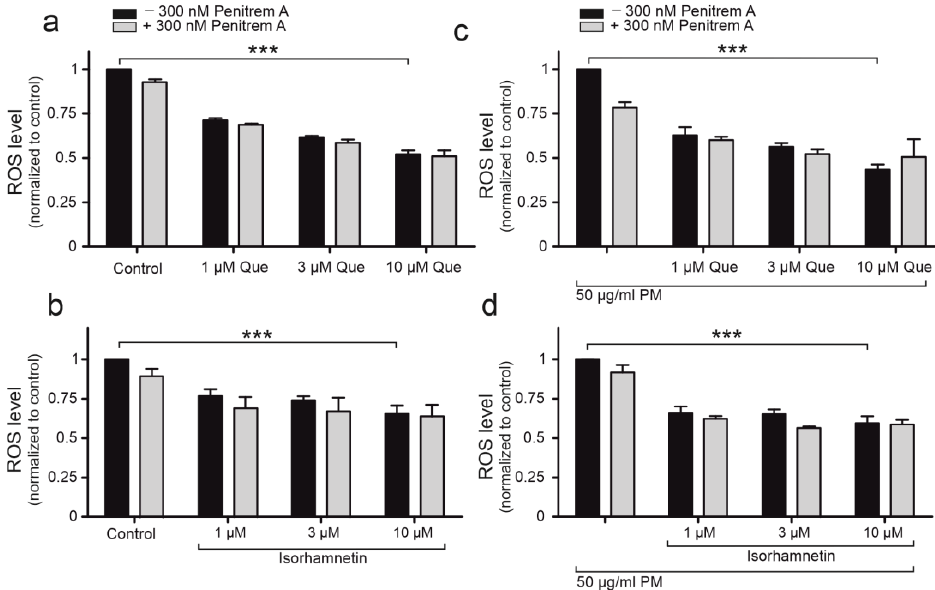
Figure 5. The influence of quercetin and isorhamnetin on intracellular ROS level. Black bars represent the effect of quercetin (1, 3, 10 µM) ( a ) and isorhamnetin (1, 3, 10 µM) ( b ) on intracellular ROS level. Influence of 50 µg/mL PM on ROS intracellular level along with quercetin (1, 3, 10 µM) ( c ), isorhamnetin (1, 3, 10 µM) with 50 µg/mL PM ( d ). Gray bars represent the data after application of 300 nM penitrem A. Data is normalized to the control values and expressed as means ± SD, n = 3. Statistical significance was determined at p < 0.001 (***) by one-way ANOVA.